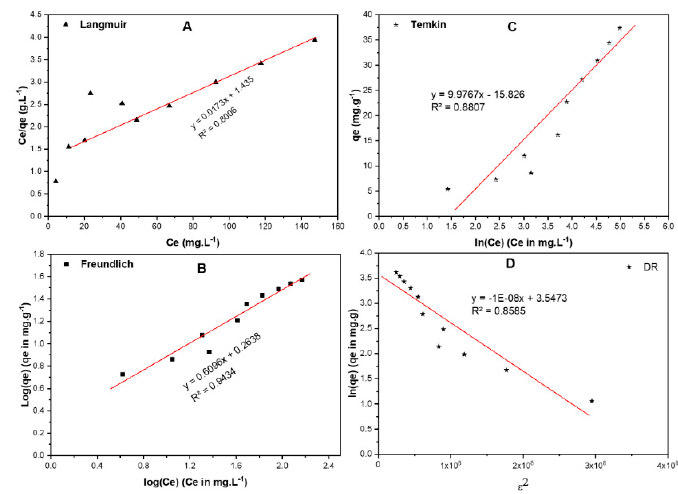
Figure 9. Adsorption isotherms of RB on RPAL including ( A ) Langmuir, ( B ) Freundlich, ( C ) Temkin, and ( D ) Dubinin–Radushkevich (DR). Table 7. General and linearized equation of Langmuir, Freundlich, Temkin and Dubinin–Radushkevich isotherms, beside their parameters for the adsorption of RB on ADPP. Isotherm Equations (Generalized / Linearized Isotherm